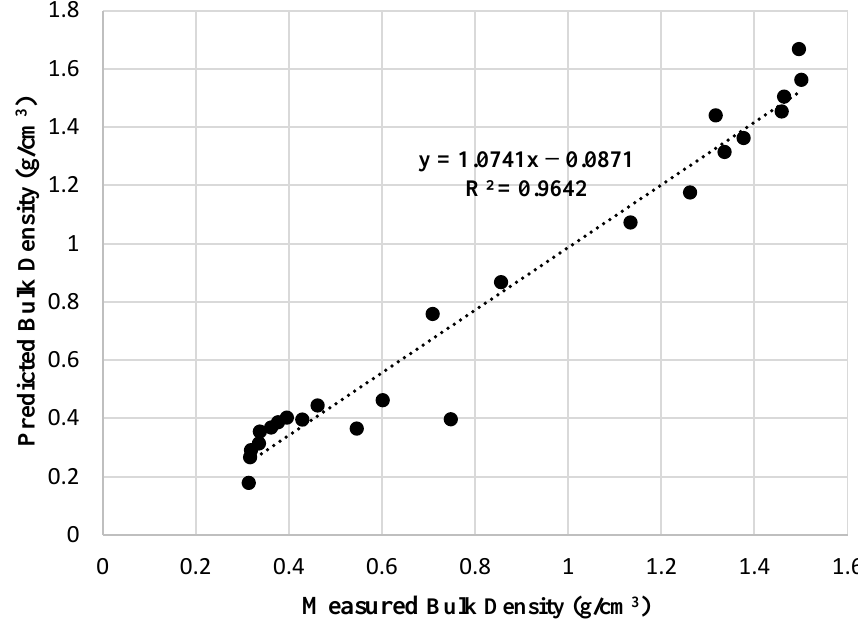
Figure 7. Predicted vs. measured bulk density.